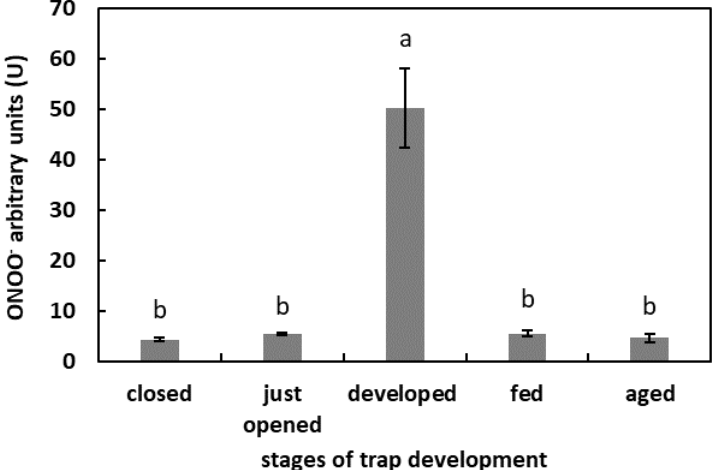
Figure 5. ONOO − generation in digestive fluid in the traps at different developmental stages: closed, just opened, developed, fed (one day after feeding), and aged. Values are average ± SD of 3 repetitions. Letters (a,b) indicate homogenous groups determined after ANOVA and post hoc Fisher’s LSD test at p ≤